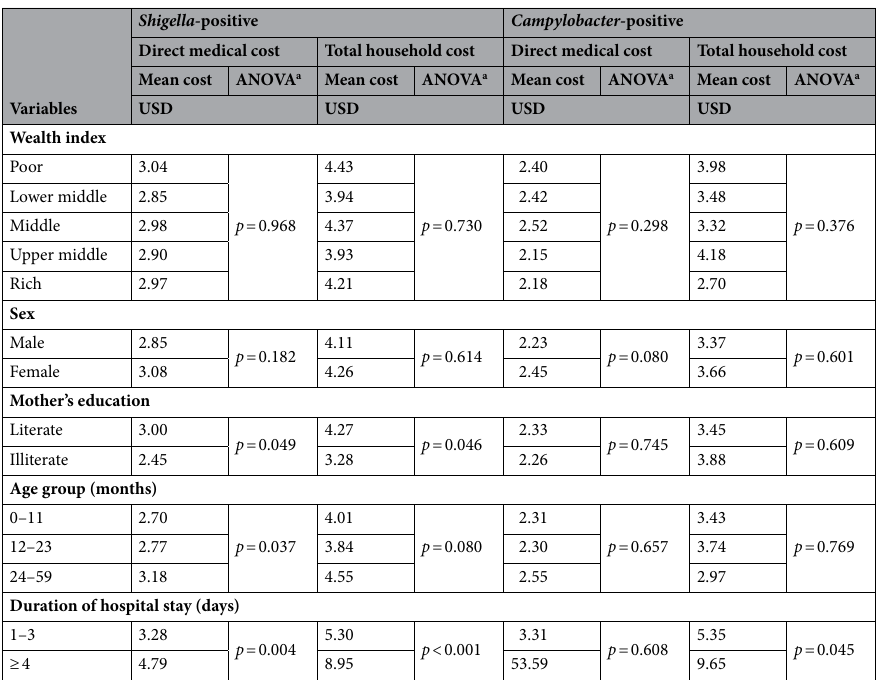
Table 4. Household direct medical costs and total household costs for Shigella and Campylobacter MSD by socioeconomic, demographic, and illness characteristics in Bangladesh. a ANOVA; Analysis of variance; USD: US Dollar; t test was conducted when categories were two.